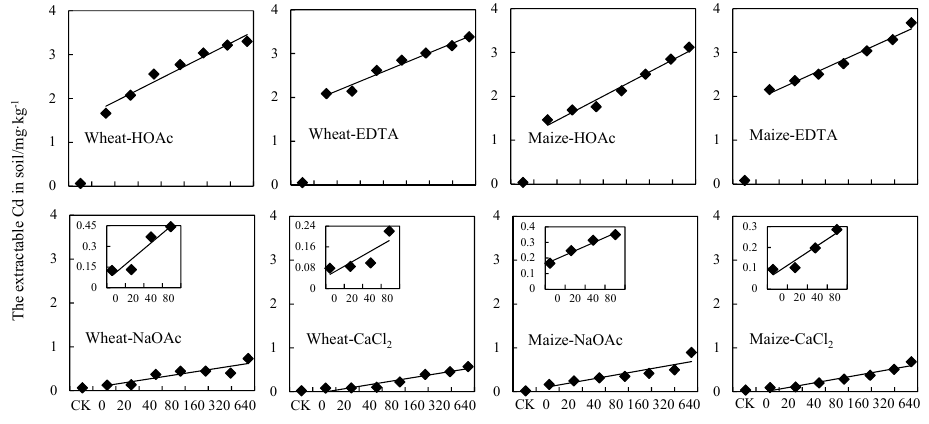
Figure 4. Bioavailable Cd measured in wheat and maize soil using four extraction methods. CK represents the control group.